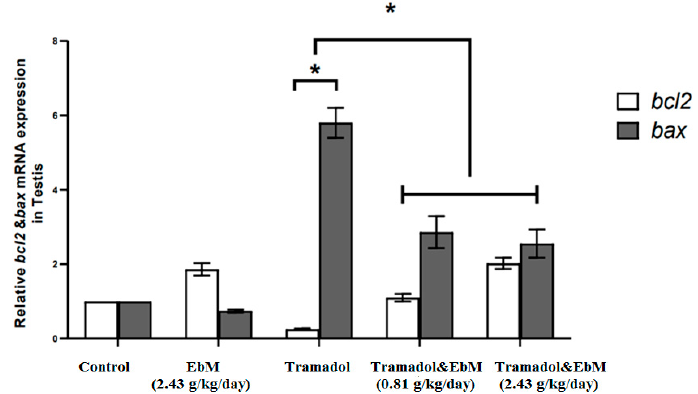
Figure 6. The effect of oral E. brevicornum extract and/or tramadol administration on the expression of apoptotic factor Bax and Bcl2 gene in testes of male rats. Tramadol-administered rats showed a